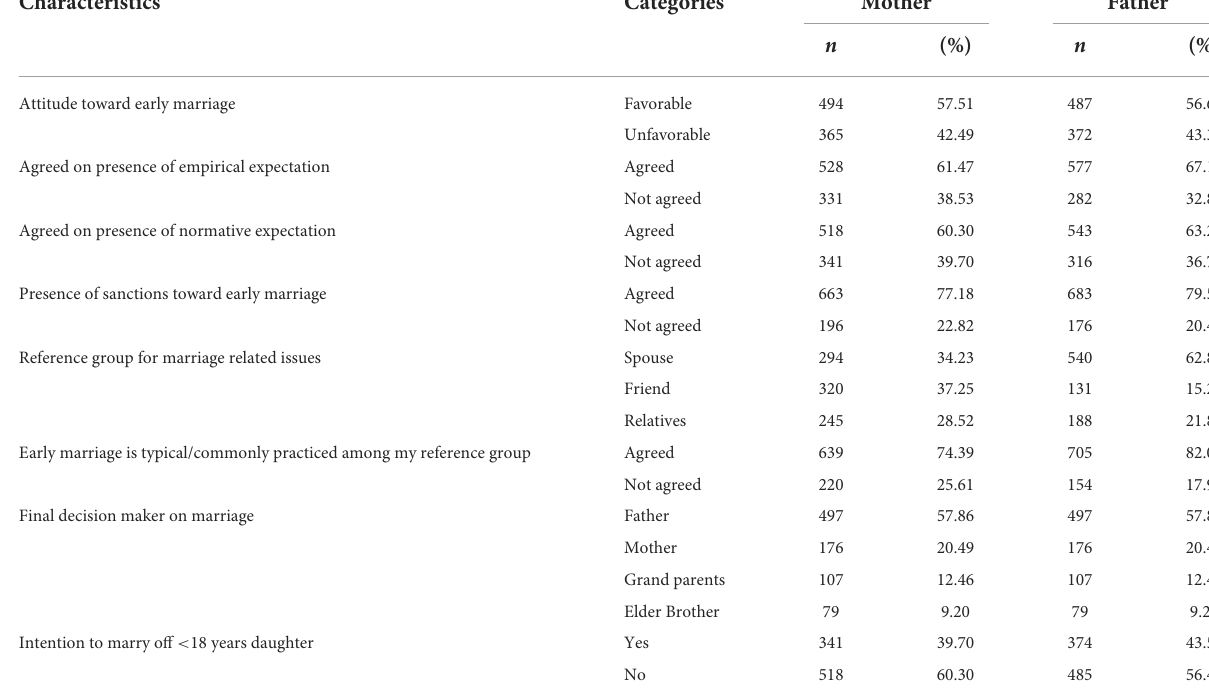
TABLE 3 Parents’ attitude and social expectations (social norms) in Kersa HDSS, Eastern Ethiopia,